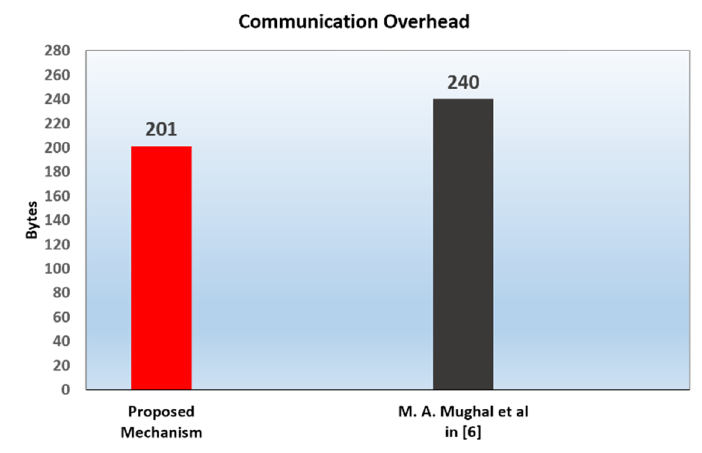
Figure 7. Comparison of communication overhead of the proposed scheme with Mughal et al.’s scheme.